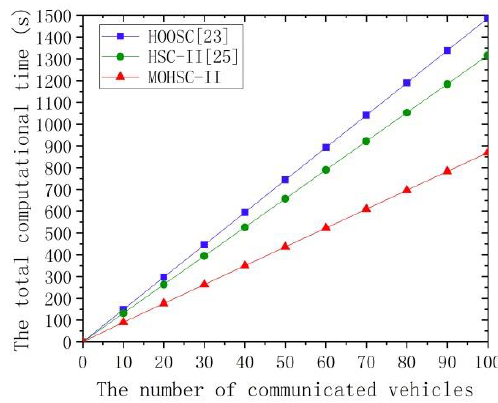
Figure 4. Comparisons of the computational time (IBC → PKI).